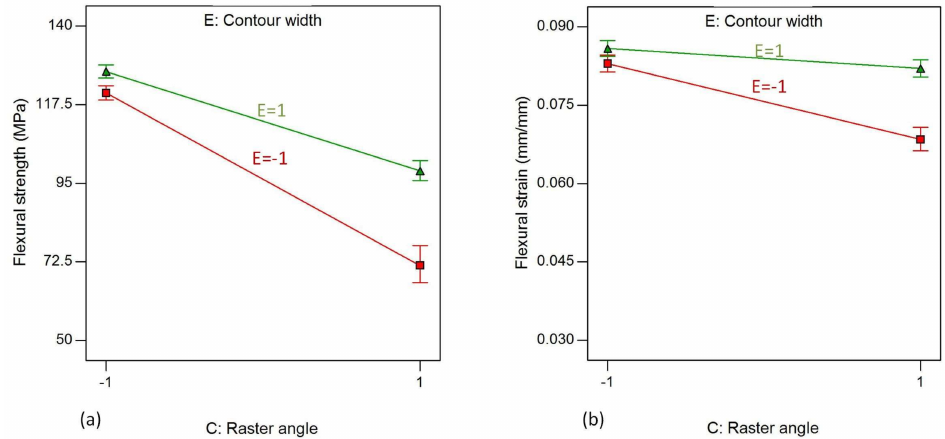
Figure 18. Interaction effect of raster angle and contour width on ( a ) flexural strength and ( b ) flexural strain, while air gap, raster width and contour number are kept at their highest level.